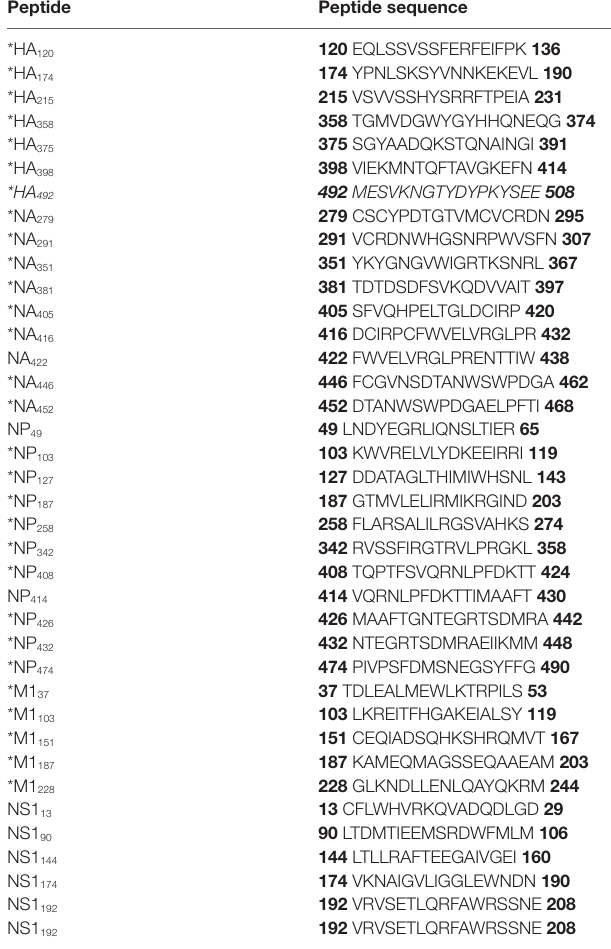
Table 1 | MHC-class II restricted epitopes